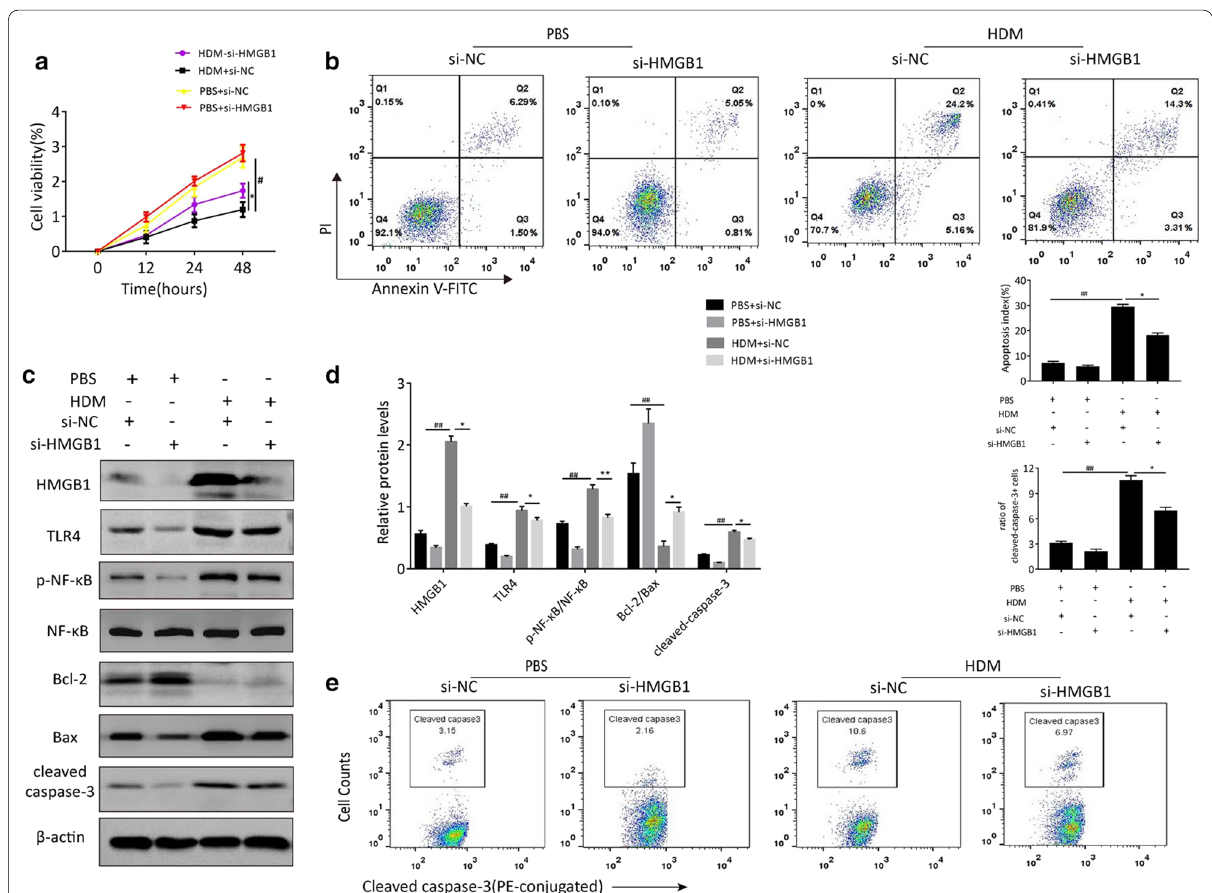
Fig. 6 HMGB1 drives airway epithelial cell apoptosis through TLR4/NF-κB signal pathway in HDM conditions. BEAS-2B cells were transfected with si-NC or si-HMGB1, and then incubated in the presence or absence of HDM stimulation. a Cell viability of si-NC or si-HMGB1 transfected BEAS-2B cells was assessed by CCK-8 assay after HDM stimulation for 12, 24, 48 h respectively. b The percentages of apoptosis cells were measured by flow cytometry. c Expressions of HMGB1, TLR4, NF-κB, p-NF-κB, Bcl-2, Bax and cleaved caspase-3 were analyzed by Western Blotting analysis. The level of β-actin served as a loading control. d Grey values of the indicated proteins were quantified by densitometric analysis. e The percentages of cleaved caspase-3 positive cells by flow cytometry. Data are shown as mean SEM. # p < 0.05 vs. PBS si-NC group (control group); ## p < 0.01 vs. PBS si-NC ± + + group (control group); *p < 0.05 vs.